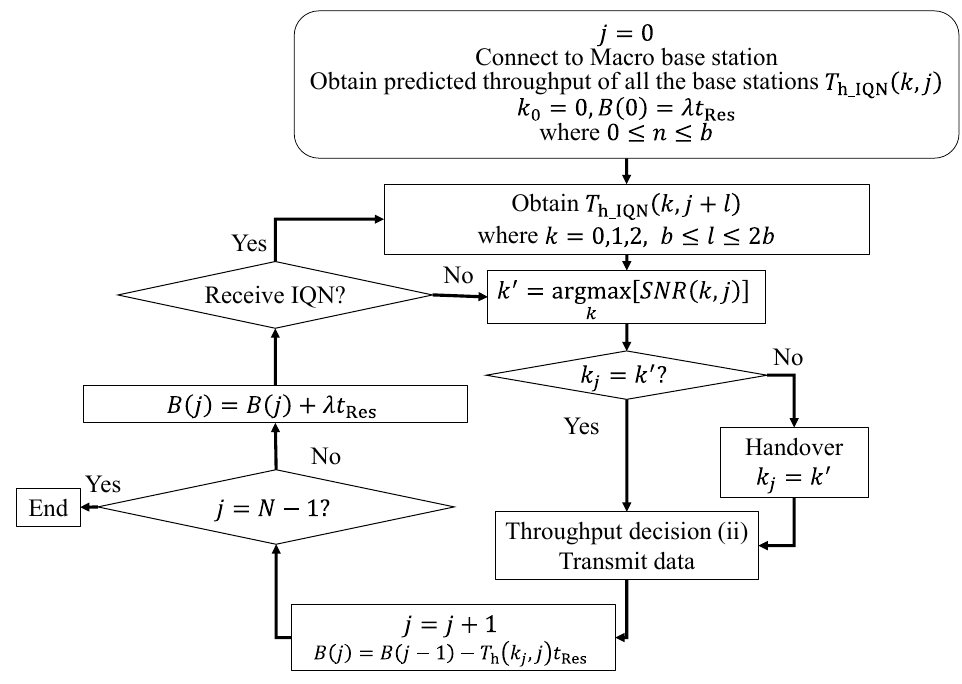
Figure 4. Transmission flowchart of vehicle.